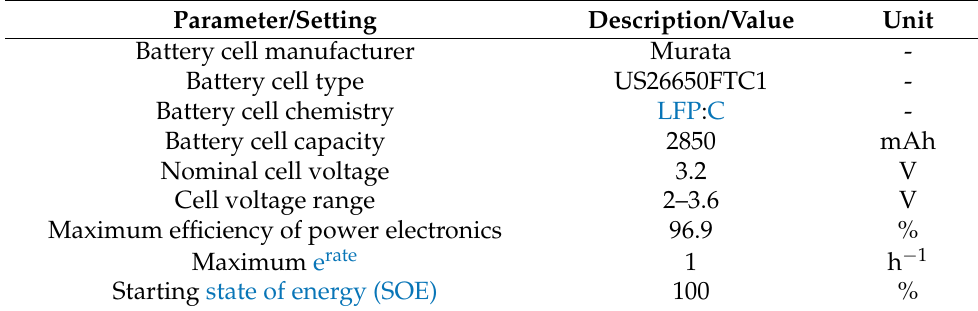
Table 1. Parameters and settings of the simulated battery energy storage system (BESS) comprising battery cells, a power electronics unit, and a battery management system